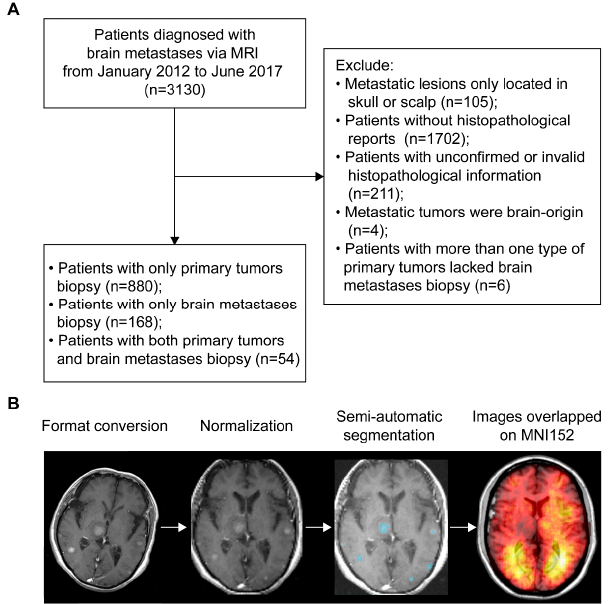
Figure 1. Patients inclusion and MRI data processing. ( A ) The workflow of inclusion and exclusion of brain metastases (BMs) patients. ( B ) Schematics of MRI data processing. The blue areas represent the regions of interest. MNI152 refers to the Montreal Neurological Institute 152 brain template and coordinate system. MRI refers to magnetic resonance imaging.